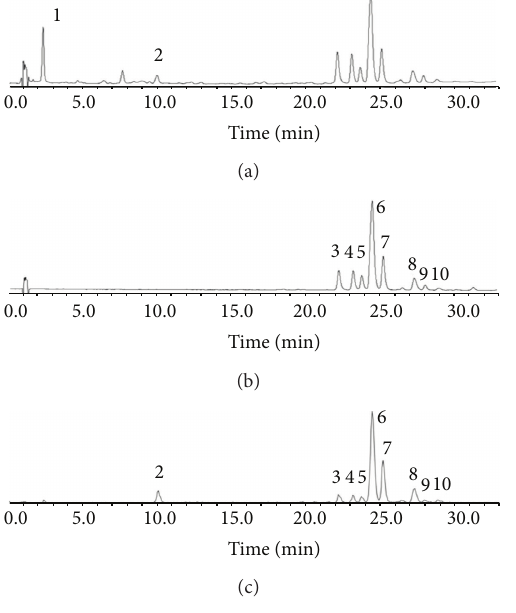
Figure 1: Chromatograms of Ximenia caffra leaf extract. (a) UV chromatogram at 280 nm; (b) UV chromatogram at 370 nm; (c) processed MS